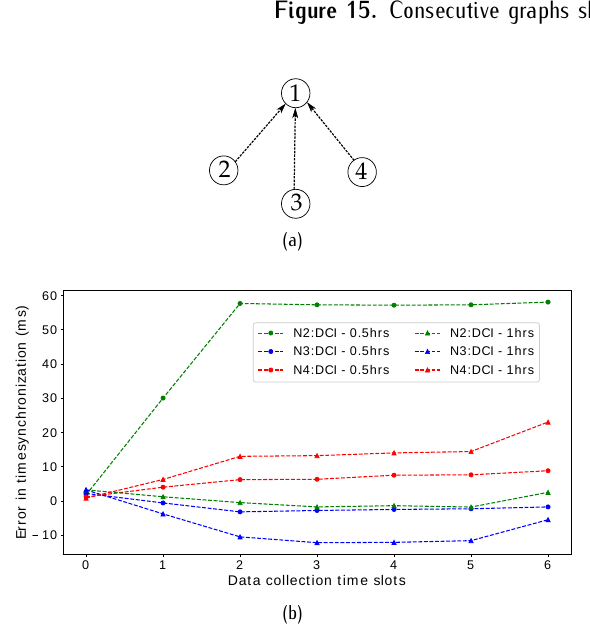
Figure 16. A singlehop network and its synchronization errors slot each node gets one reference point from its parent random errors and hence, we cannot guarantee that the nodes farther from the sink node will have larger errors. The same applies to time synchronization errors with di ff erent data collection intervals.